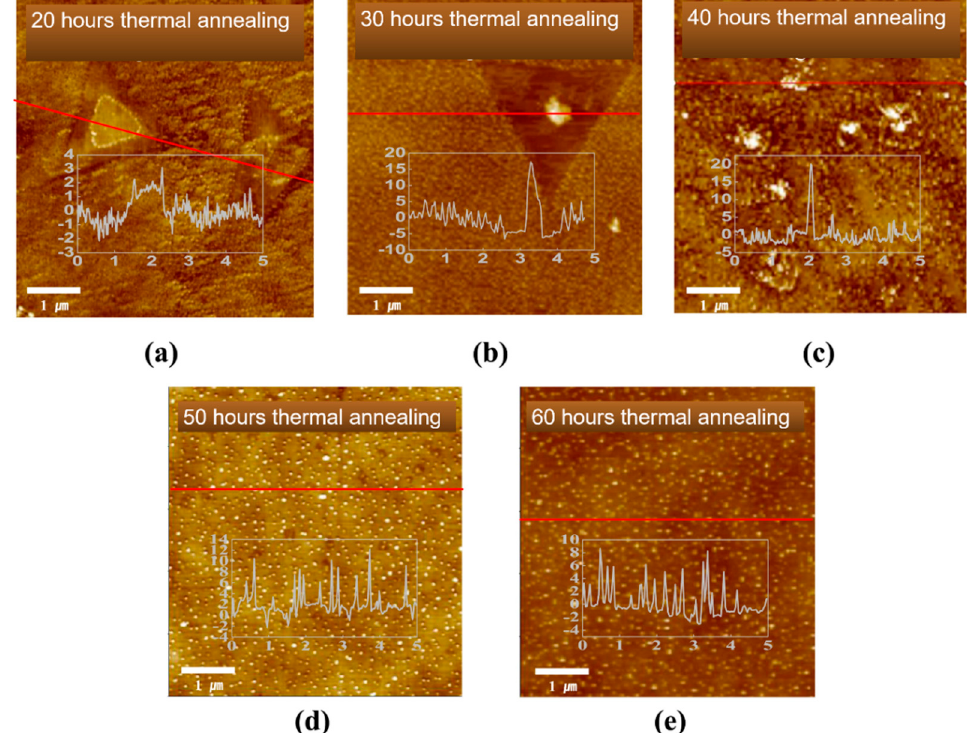
Figure 12. ( a – e ) AFM image and cross-sectional plot after thermal annealing at temperatures of 500 °C for 20, 30, 40, 50, and 60 h, respectively. The X-Y ranges of ( a – e ) are 5 µm and the X-Y ranges in the cross-section plots of the inset figures are µm and nm, respectively. Reproduced with permission from [72] . Elsevier B.V., 2017.